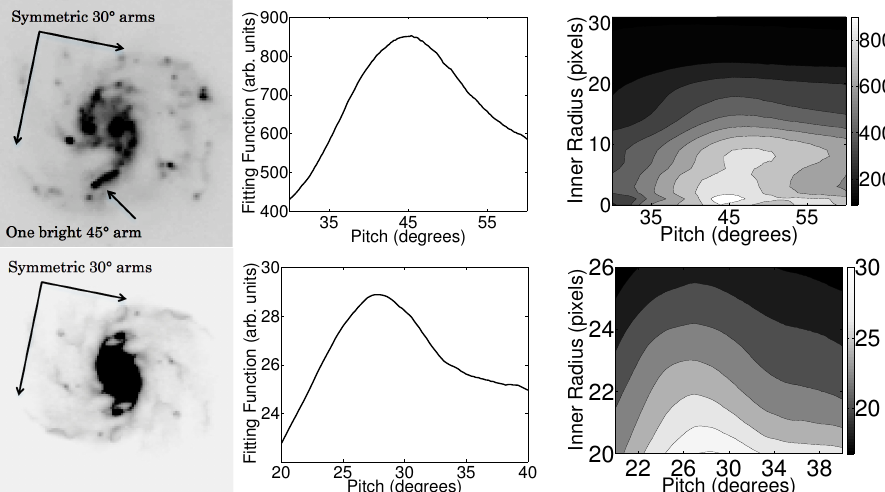
Figure 5. Spirality measurements of the galaxy UGC 4256, both the entire galaxy ( top row ) and the 2-arm component ( bottom row ). Top row, left to right: B -band image of the entire galaxy, fitting function vs. pitch angle at a fixed inner radius, fitting function vs. both pitch angle and inner radius. Bottom row: Same as top row, but for the galaxy’s 2-arm (180 ◦ rotationally symmetric) component, which was computed by SymPart. Note that in each row, the center panel is a cross section of the right panel. For the whole galaxy, Spirality yields a measurement of 45.1 ◦ ± 3.8 ◦ , which is consistent with transparency overlay for the single bright spiral. For the 2-arm component, Spirality yields a measurement of 27.2 ◦ ± 4.1 ◦ , which is consistent with 2DFFT’s 29.1 ◦ ± 4.3 ◦ measurement of the 2-arm